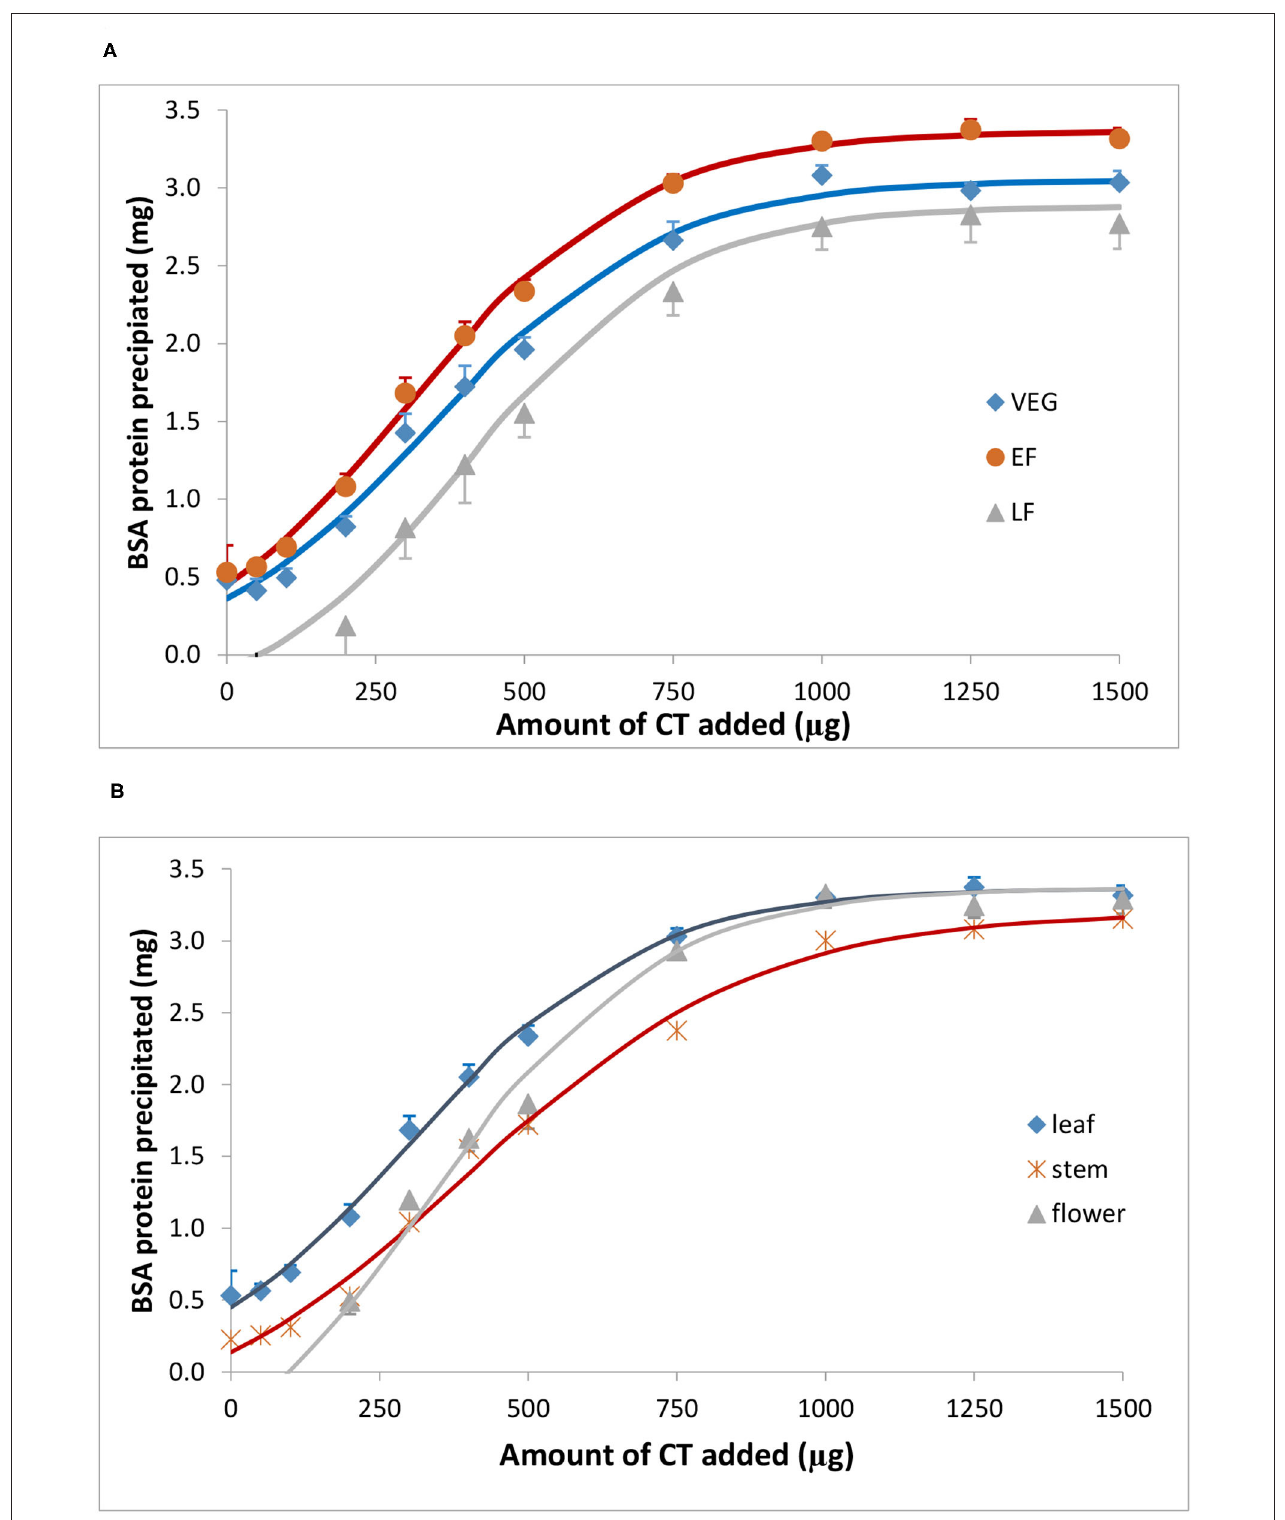
FIGURE 4 | Precipitation of bovine serum albumin (BSA) by CT isolated from the leaves of PPC ( Dalea purpurea Vent.) at VEG, EF, and LF stages (A) , and from leaves, stems, and flowering heads at early flowering heads (B) . Lines relate to corresponding CT data which were fitted to a SigmaPlot curve as described under statistical analysis. Bars indicate standard error and where not visible, fall within